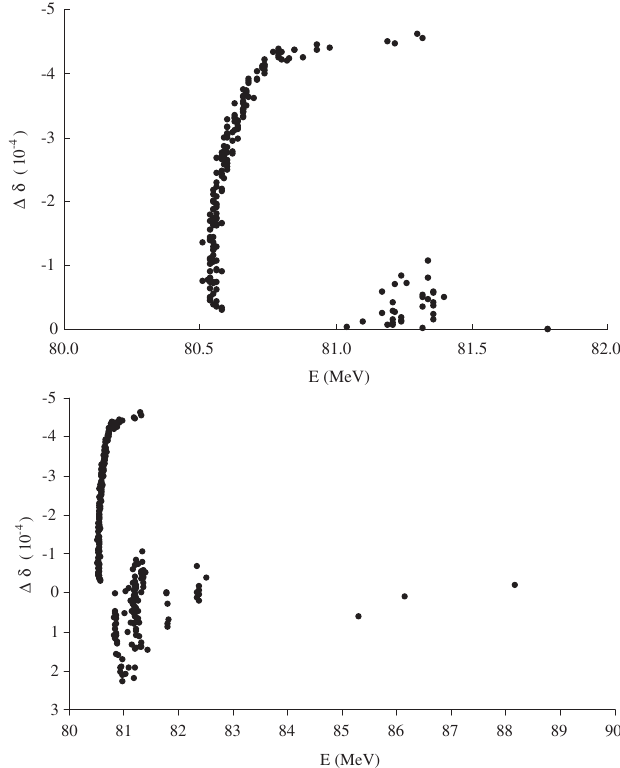
FIG. 2. Precession per turn in momentum deviation for the lost particles. Simulation conditions: CSNS RCS, 1D simulation, 0.83 chopping factor or 17% beam chopped, 0.1% off- momentum injection, a few particles of higher energy not shown. Upper: one-side collimation by (cid:1) 1% in momentum deviation; lower: two-side collimation by (cid:4) 1% in momentum